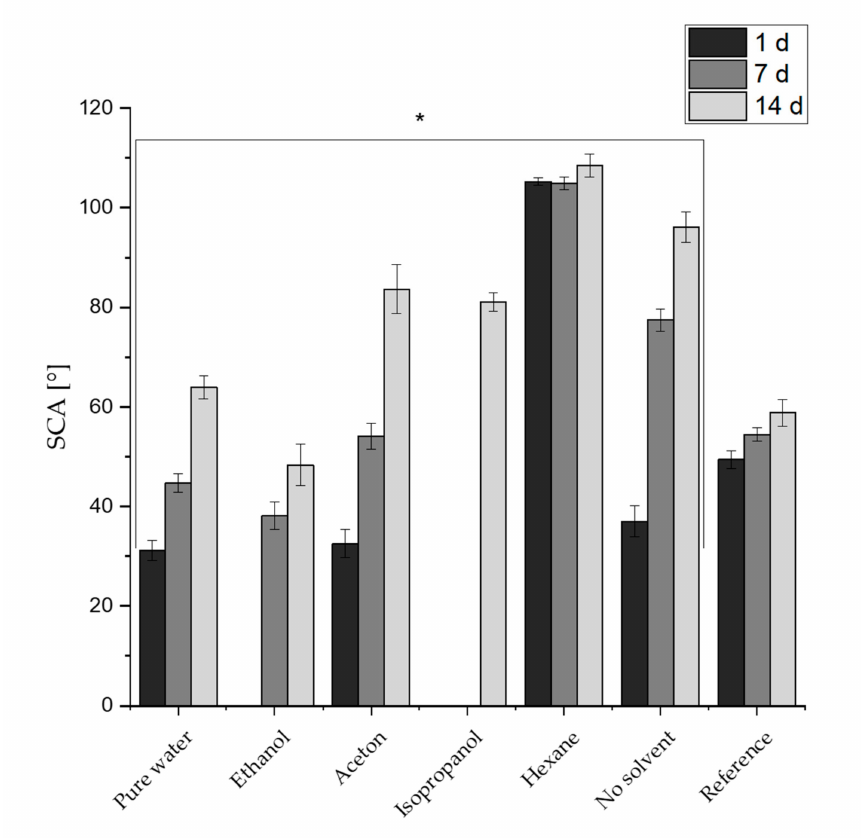
Figure 2. Static contact angles (SCA) on reference and structured specimens (indicated by (*)) as a function of time and used cleaning